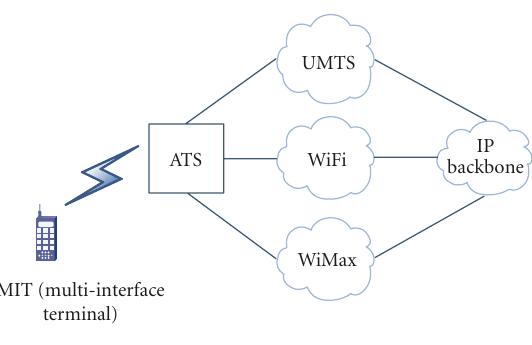
Figure 1: Key elements of an ABC system.